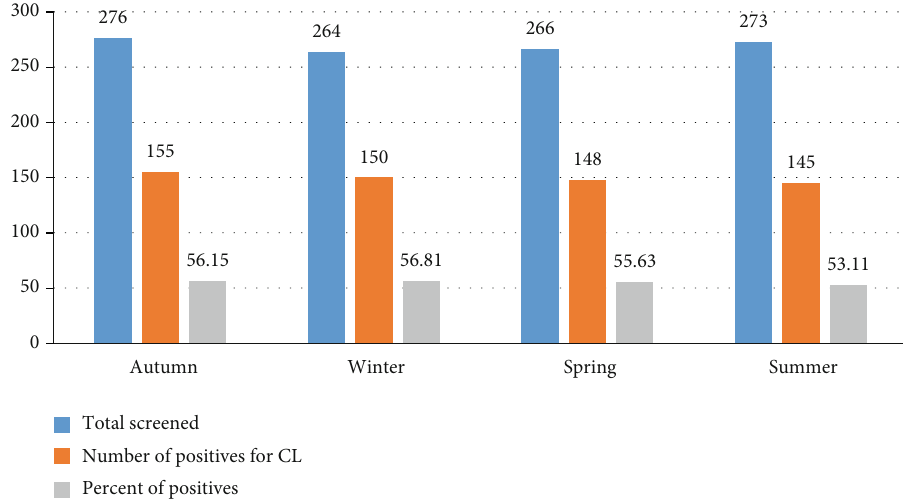
Figure 3: Distribution CL suspected and con fi rmed cases among di ff erent seasons at LRTC, University of Gondar, Ethiopia